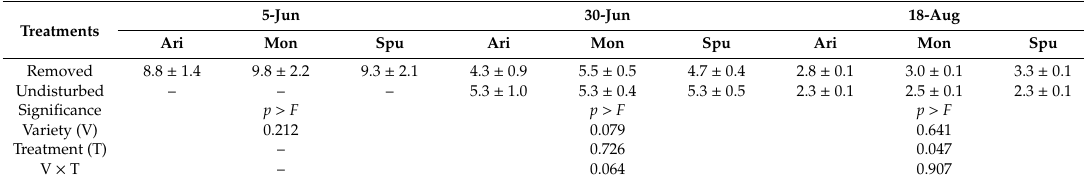
Table 9. Average ( ± standard error) ABA content (ng g − 1 fresh weight) in tubers of plants early “Removed”, and in tubers of plants left “Undisturbed” on field until the date of harvesting (Experiment 2).